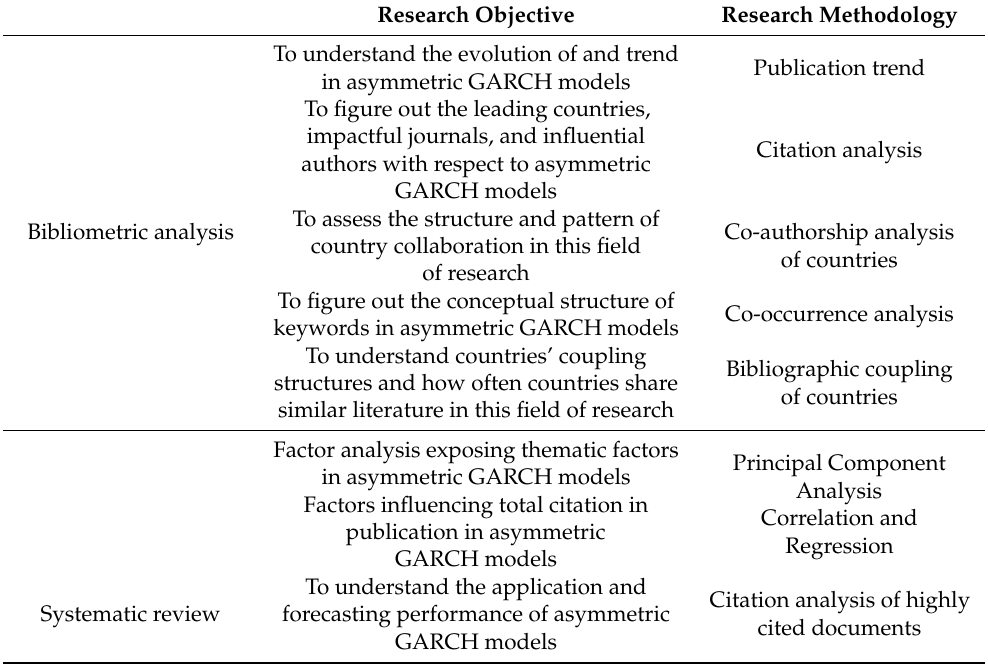
Table 1. Overview of Research Objective and